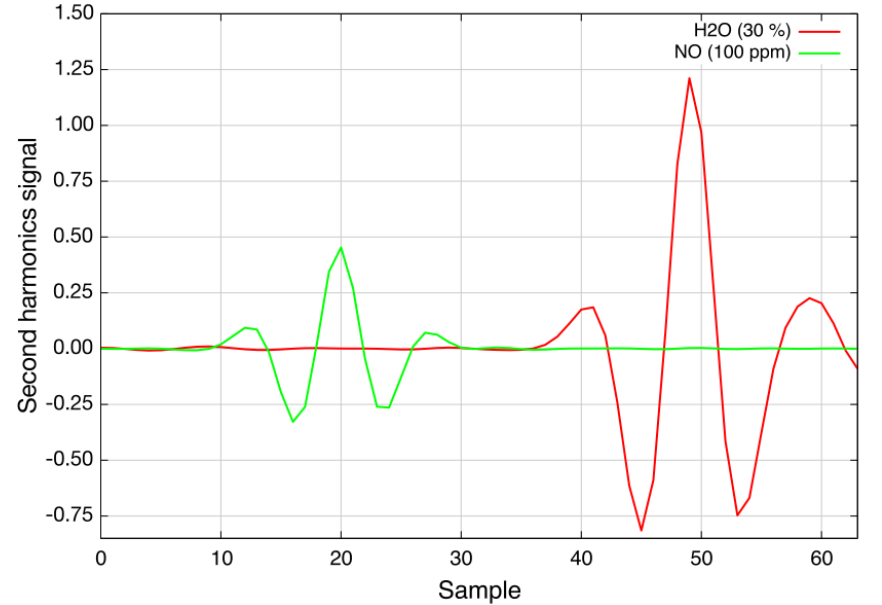
Figure 7. Second harmonic spectra of 30% water vapor (red) and 100 ppm nitric oxide (green) at 400 °C (OPL = 70 cm, p = ambient). The total wavelength tuning is approximately 0.6 cm − 1